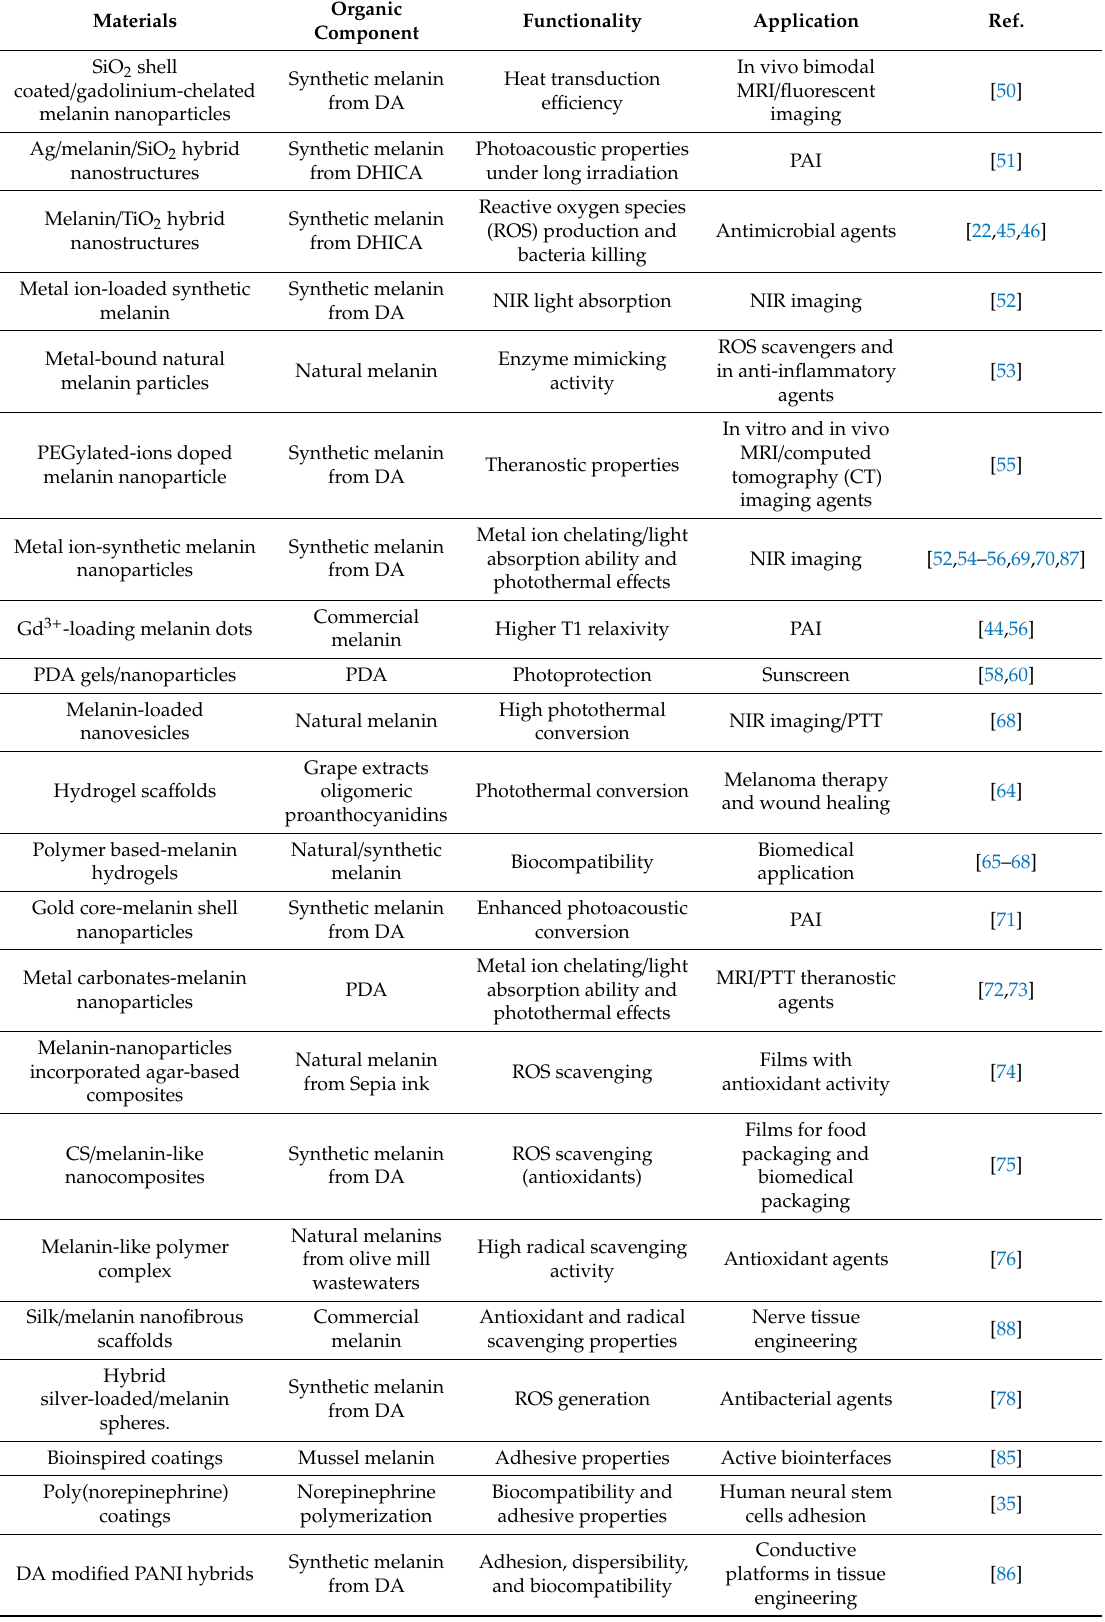
Table 1. Summary of melanins and melanin-like hybrid